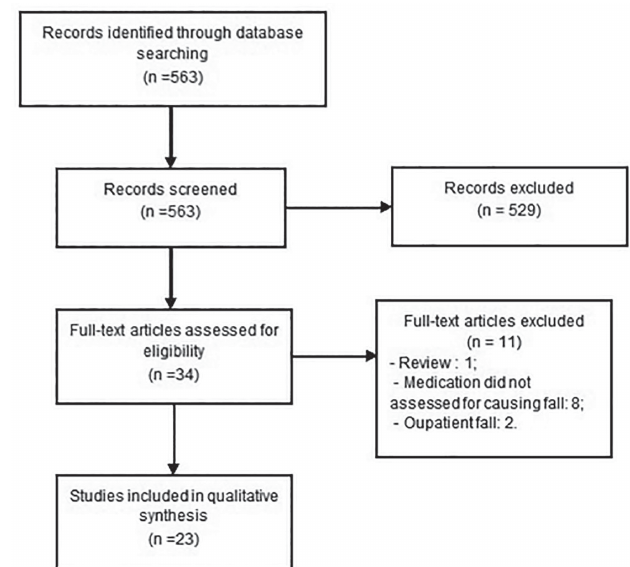
FIGURE 1 - Flowchart of studies selection according to PRISMA,